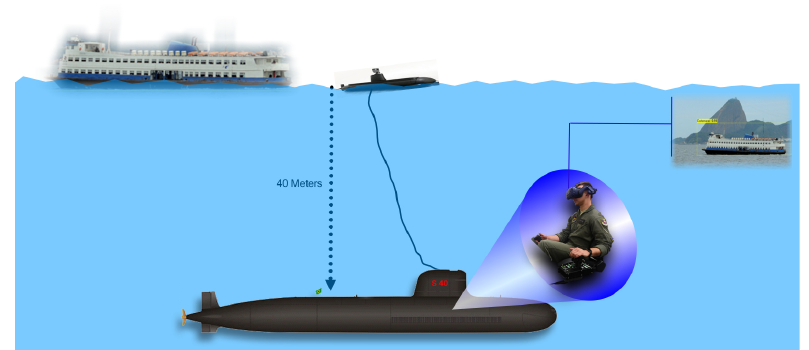
Figure 2. Overview of the proposed solution.